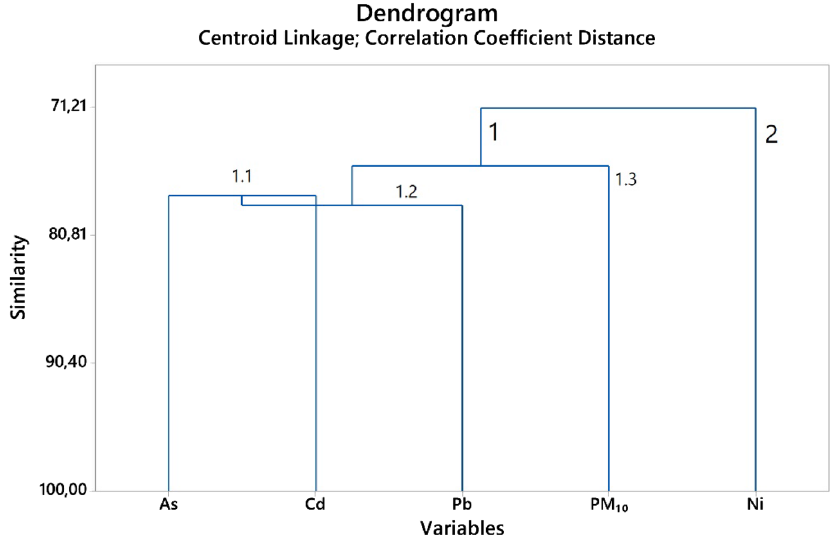
Figure 4. Cluster analysis of trace elements and PM 10 . The dendrogram was prepared using Minitab 17.3.1 statistical